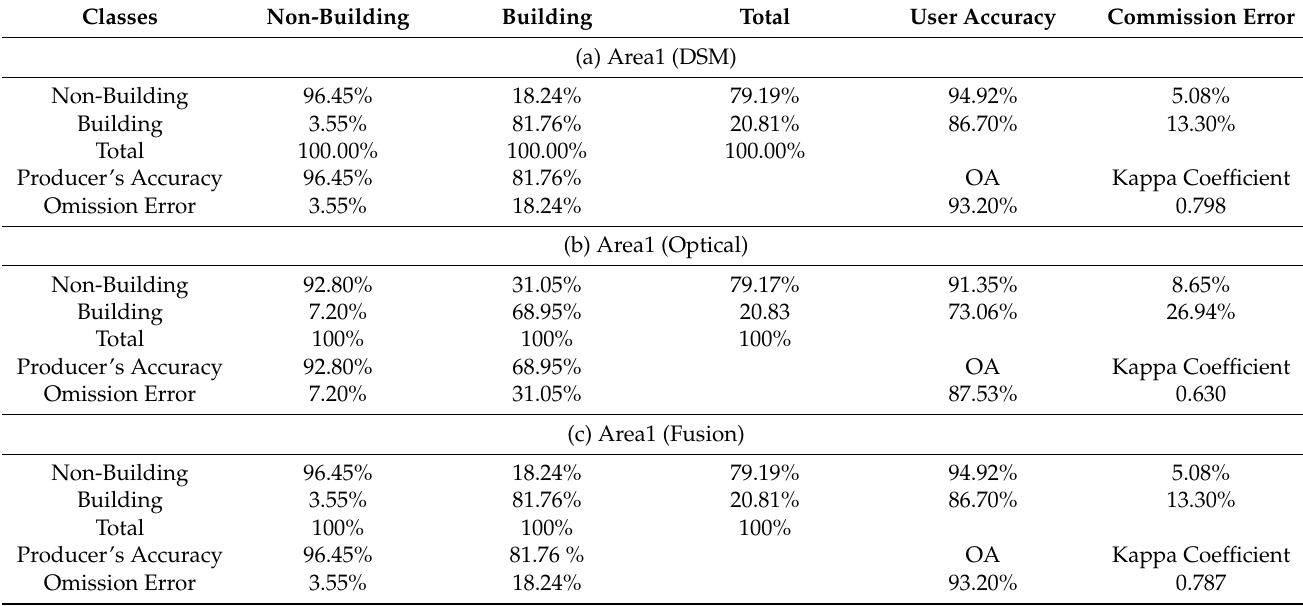
Table 1. The confusion matrix using the proposed method for